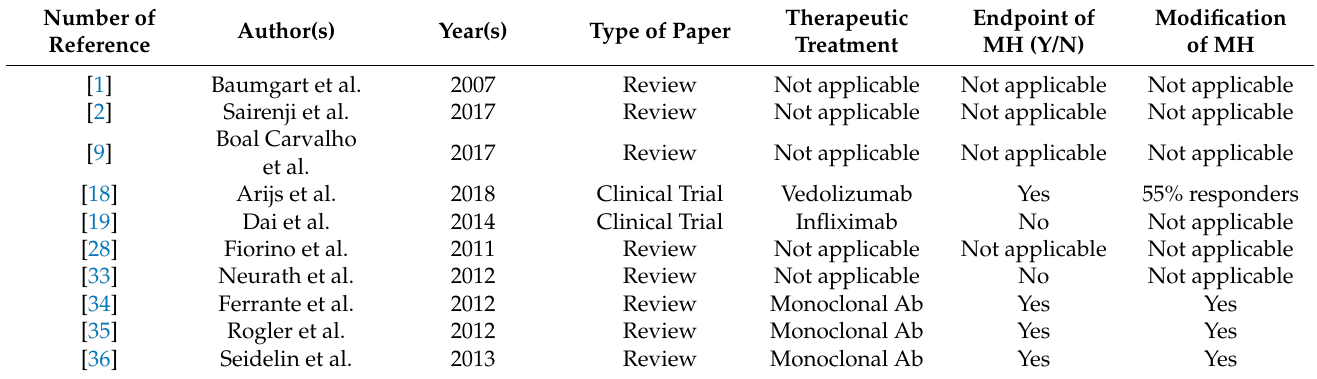
Table 2. Main studies used in the realization of this